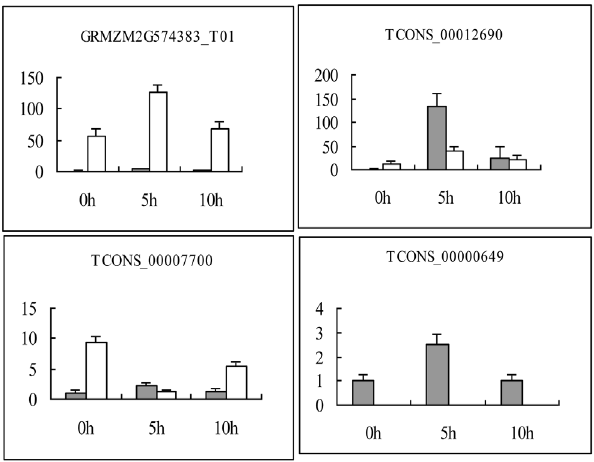
Figure 6. Quantitative analysis of 4 other lncRNAs in the leaves and roots using RT-qPCR at 0, 5 and 10 h. The gray bar denotes the leaf samples and the white bar denotes root samples. GAPDH RNA was used as the internal control. Error bars indicate SD obtained from three biological repeats.